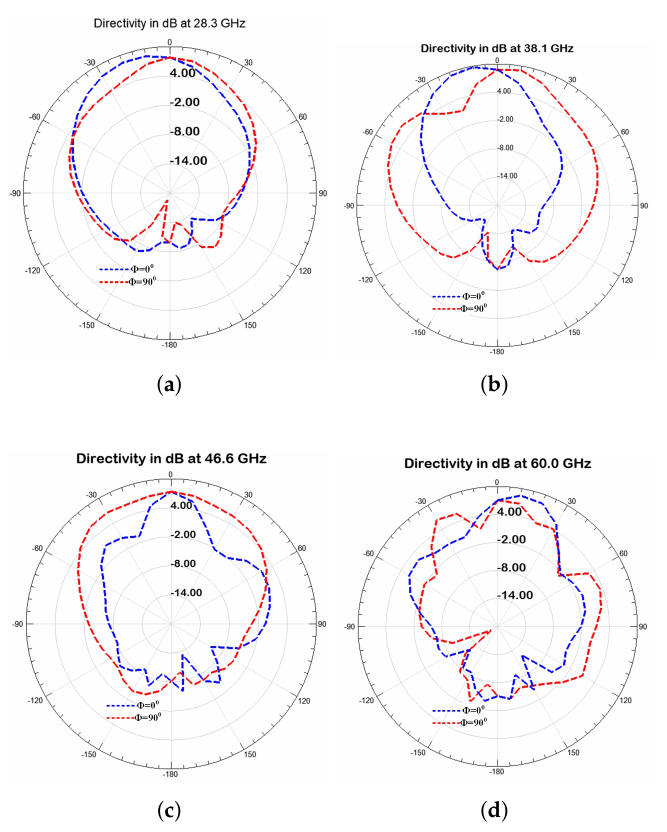
Figure 8. The 2D radiation pattern plot of the proposed antenna in dB ( a ) at 28.3 GHz, ( b ) at 38.1 GHz, ( c ) at 46.6 GHz, and ( d ) at 60.0